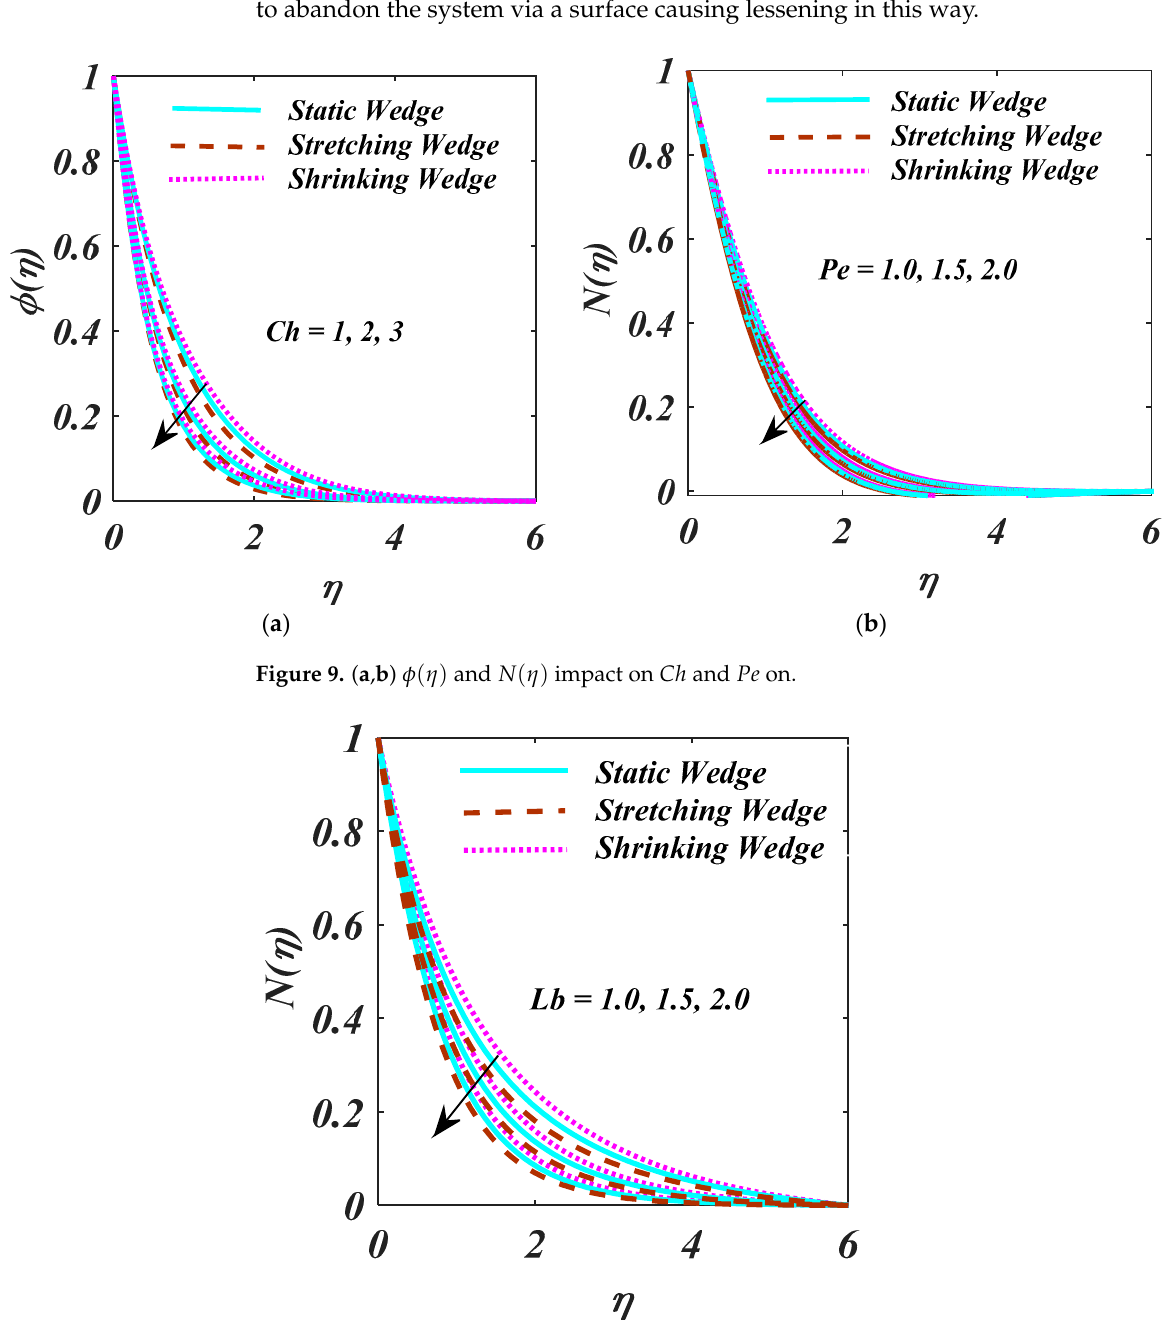
Figure 8. ( a , b ) (cid:2016)(cid:4666)(cid:2015)(cid:4667) and (cid:2038)(cid:4666)(cid:2015)(cid:4667) impact on (cid:1840)(cid:1854) .